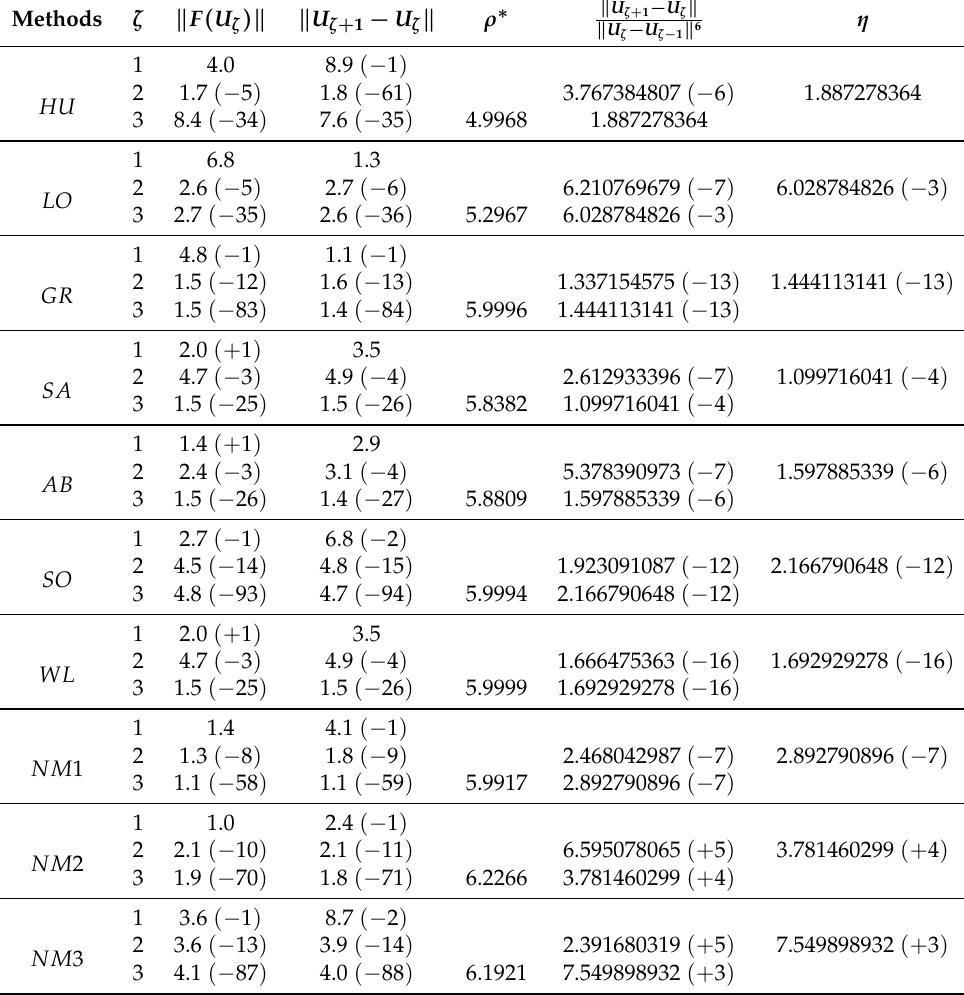
Table 2. Conduct of different techniques in Fisher’s Equation